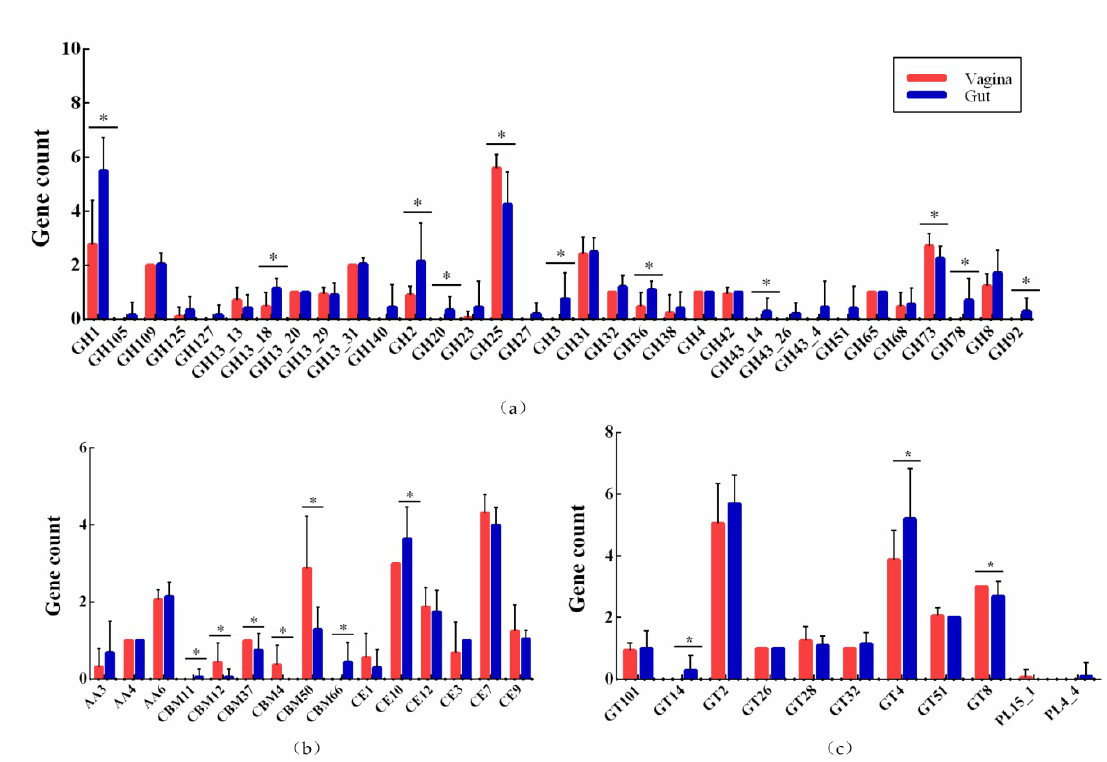
Figure 6. Distribution and abundance of active carbohydrate enzyme family genes in L. crispatus strains isolated from feces and vagina. * p <